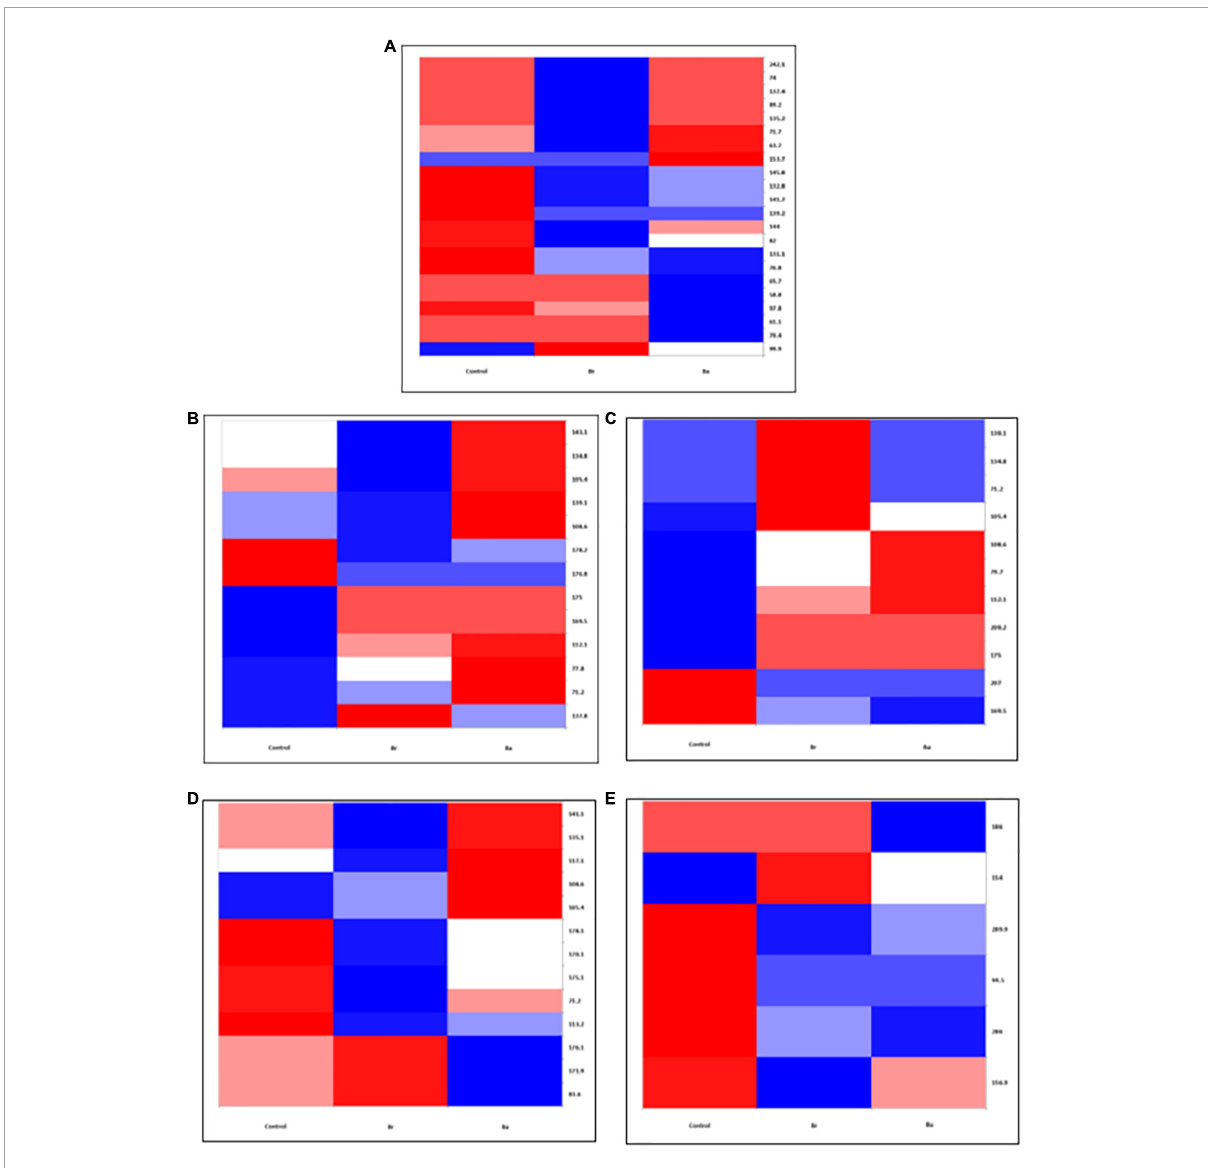
FIGURE2 Heatmap displaying the occurrences of the common bacterial operational taxonomic units (OTUs) identified, as T-RFs, in the soils treated with Beauveria brongniartii (Br) and Beauveria bassiana (Ba) bioinocula and untreated (Control) in the field located at Brzostówka (BRZ) as sampled during the 3 years. The color represents the OTU intensity: Blue to red, min to max. The absence of OTU is displayed as white line. The intensity of the color represents the percentage of occurrence in the treatments. Samples were collected in (A) September 2014, (B) June 2015, (C) September 2015, (D) May 2016, and (E) July